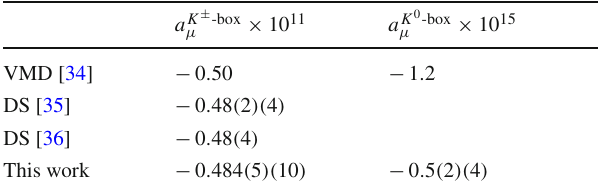
Table 2 Results for the charged and neutral kaon-box contributions to HLbL